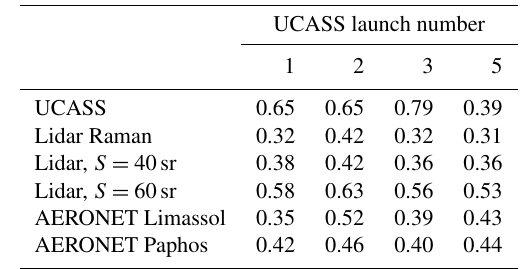
Table 2. Column AOD derived from the integration of the extinction coefficient profiles in Fig. 8 for the times of the UCASS launches (see Table 1). AODs are also shown in Fig. 1a. UCASS and lidar AODs are at 532nm. AERONET AOD is at 500nm. Lidar Raman refers to the Raman solution of the lidar equation while the other two lidar values refer to an analysis following Klett’s method with lidar ratios of 40 and